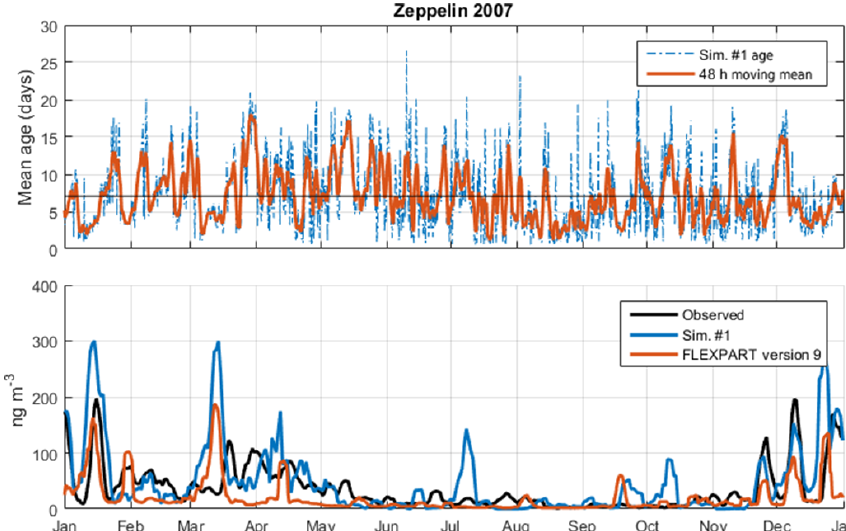
Figure 9. Top panel: age of FLEXPART BC aerosol for simulation #1 at Zeppelin every 6h (blue) and smoothed with a 48h running mean (red) for the year 2007. The black line shows the annual mean age of 7.7 days. Bottom panel: observed (black) BC concentrations at Zeppelin and the simulated FLEXPART concentrations for simulation #1 and FLEXPART version 9 (blue and red respectively). All data are smoothed with a 48h running